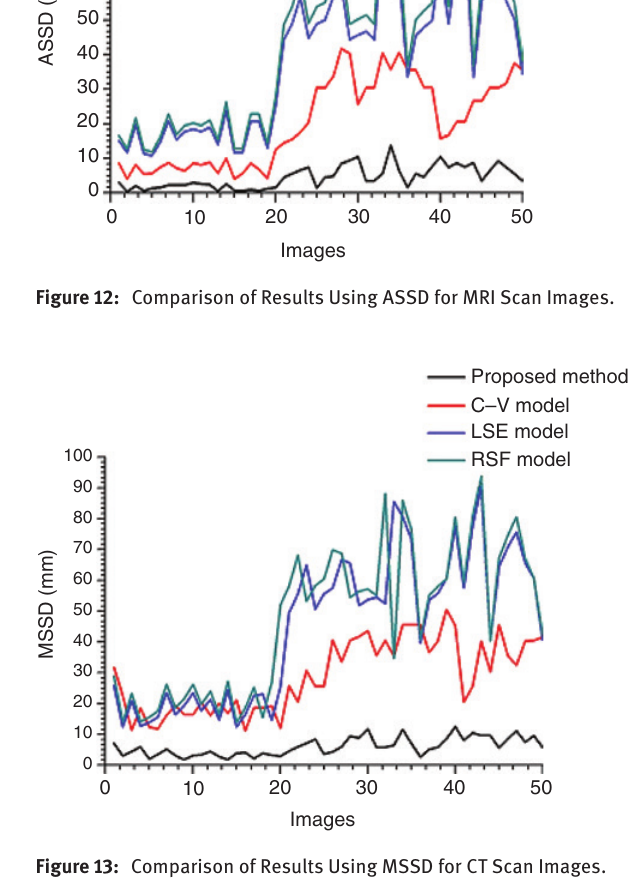
Figure 13: Comparison of Results Using MSSD for CT Scan Images.